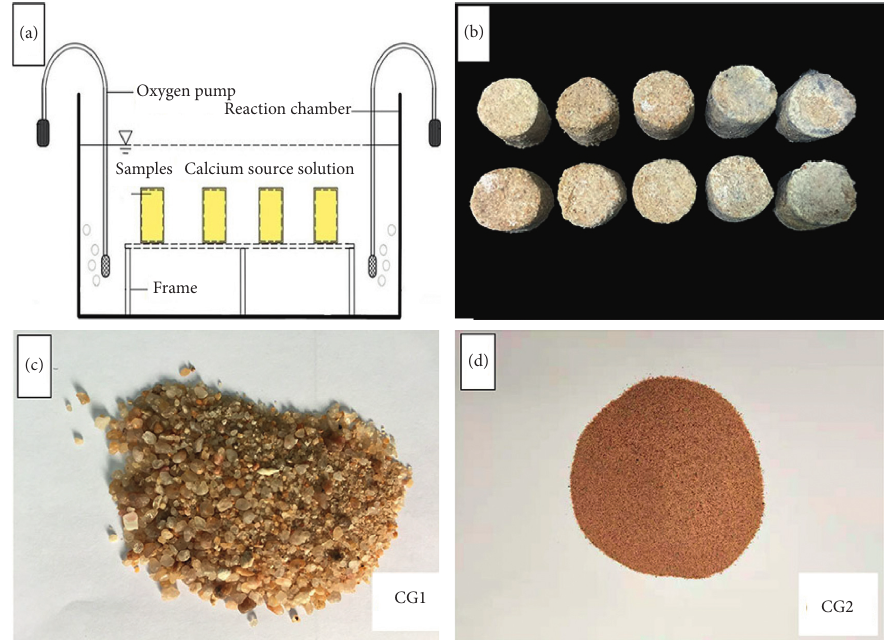
Figure 4: (a) Microbial mineralization reactor, (b) mineralization samples, (c) standard silica sand (CG1), and (d) Aeolian sandy soil